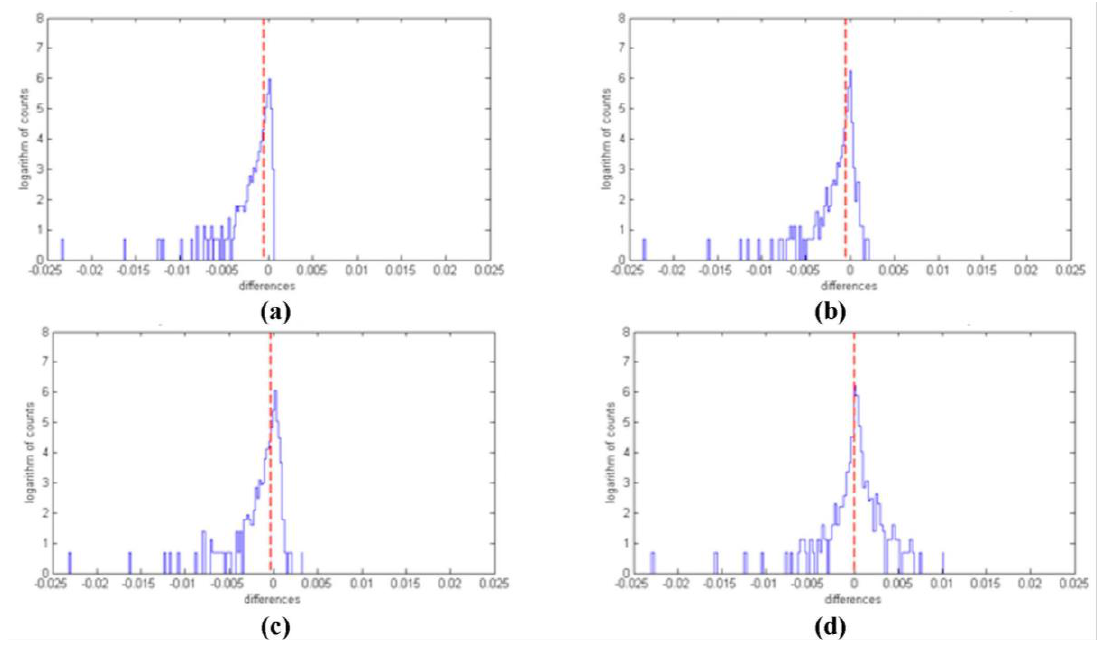
Figure 9. Bar charts of a specific simulation scenario comparing the difference between the average simulation output and the actual data. ( a ) Scenario 1: No realistic information about entrances, exits, or heat maps; ( b ) Scenario 2: realistic entrance/exit probabilities but disabled heat maps; ( c ) Scenario 3: realistic heat maps but disabled entrance/exit probabilities; ( d ) Scenario 4: realistic entrance/exit probabilities and heat maps